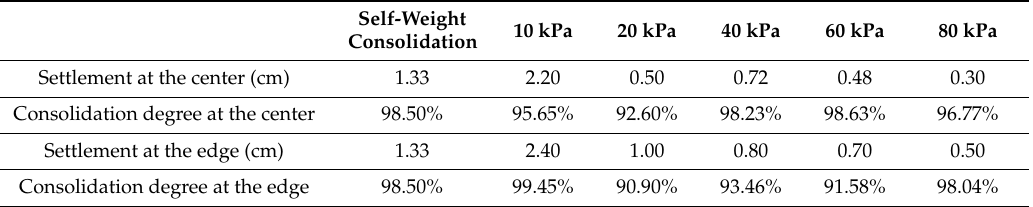
Table 5. Settlement and consolidation degree in di ff erent stages.